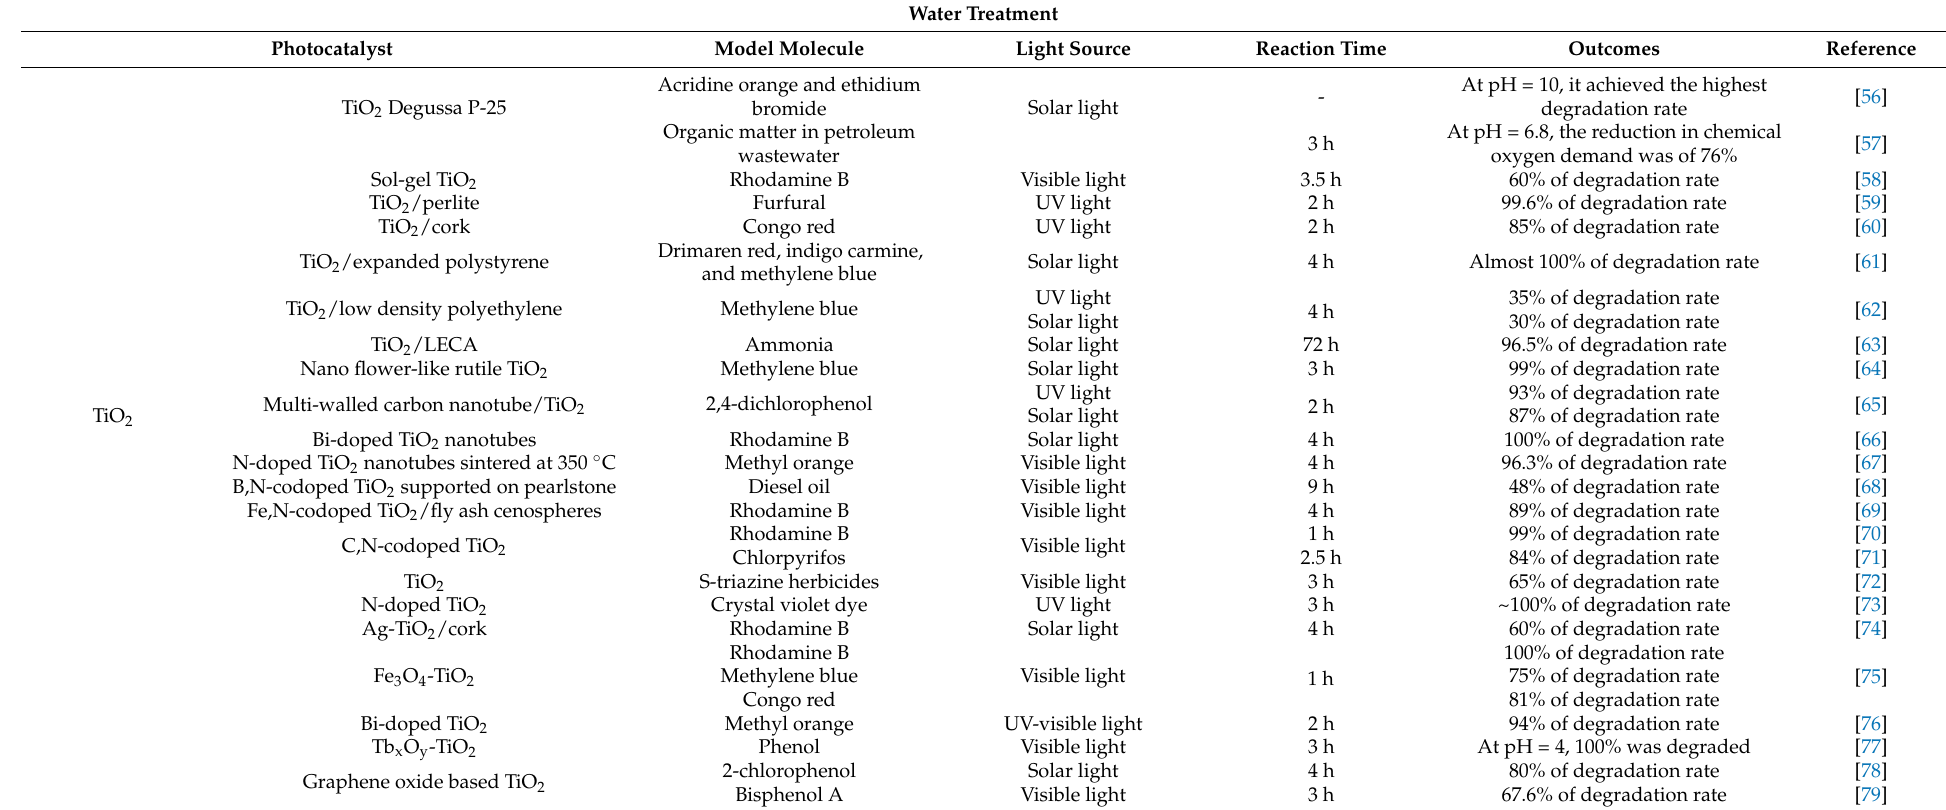
Table 2. Selected examples of photocatalyst materials commonly synthesized for water treatment and green hydrogen